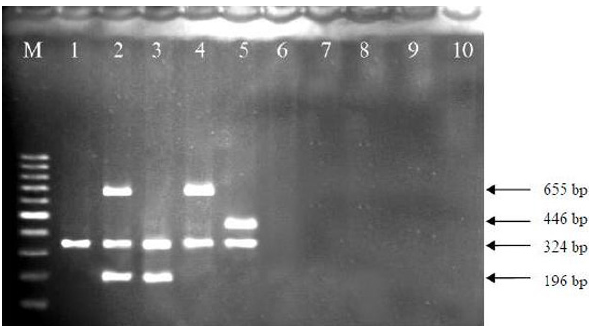
Figure 2. Standard strains, positive and negative controls. M: marker (DNA ladder, 100 bp); lanes 1 to 4: positive controls, standard strain of C. perfringens types A, B, C and D; lanes 5 to 9: negative controls, C. septicum , C. sordellii , C. sporogenes , C. leptum and C. ramosum .